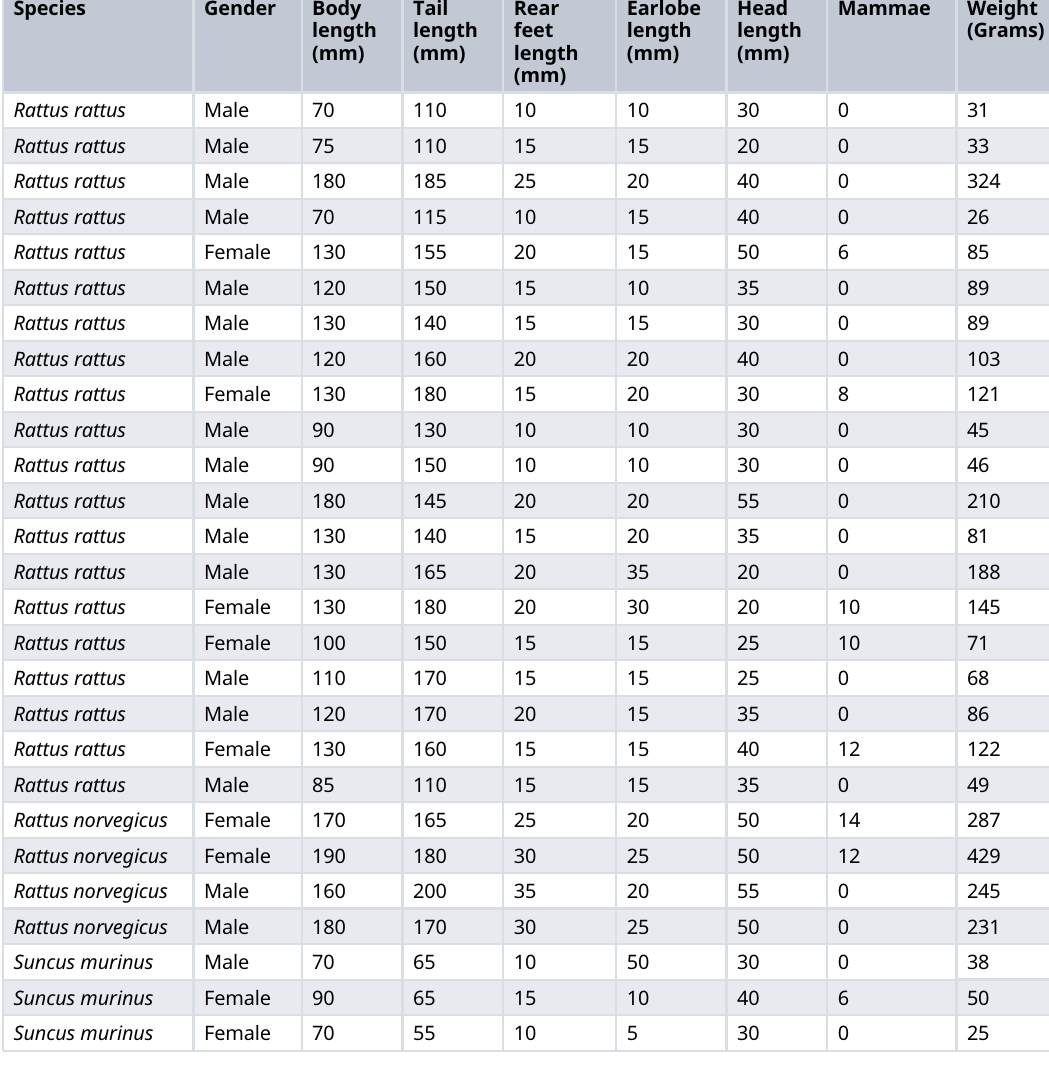
Table 2. Characteristics of rats and shrews caught in West Jakarta, November 2019.